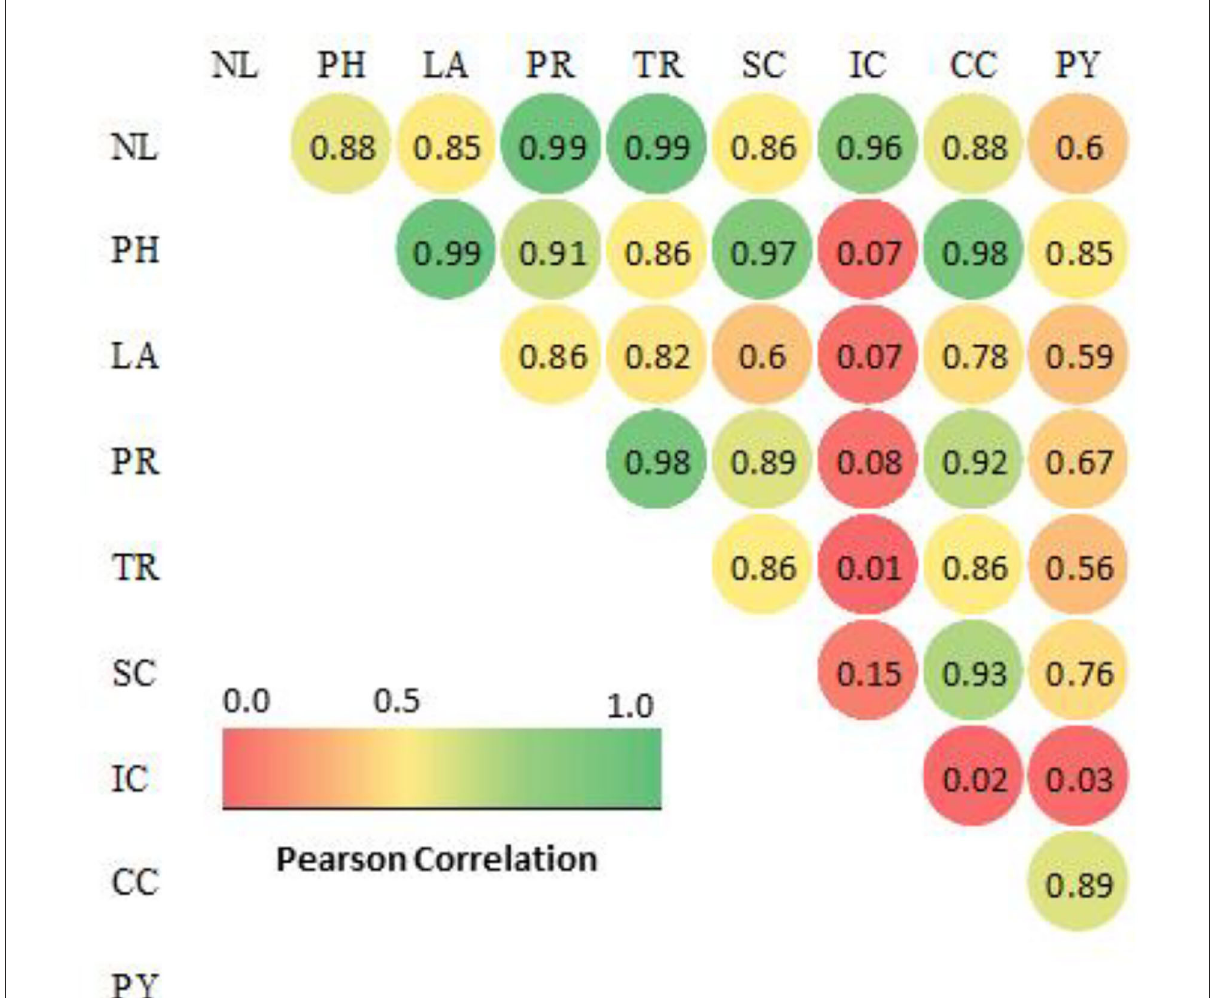
FIGURE1 Correlation matrix of plant growth and physiological characteristics in H 2 O 2 treated F. deltoidea plants under drought conditions[[Inline Image]]. The labels of data are similar in Tables 1, 2. Nl, number of leaves; PH, plant height; LA, leaf area; PR, photosynthetic rates; TR, transpiration rates; SC, stomatal conductance; IC, internal CO 2 concentration; CC, chlorophyll content (SPAD); PY, photosynthetic yield (Fv/Fm). The colored gradient legends represent coefficients of correlation r values from 1.0 (green), 0.5 (yellow) and 0.0 (red). The value > 0.9a strong correlation, > 0.8a fair strong correlation and > 0.6a moderately strong correlation at p value 0.05 .